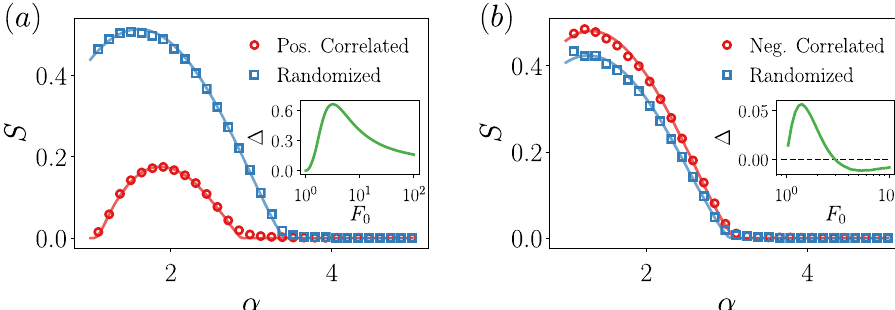
Fig. 3 Percolation in correlated degree-feature networks. Size of the giant connected component for ( a ) the positively correlated distribution Eq. (10) and for ( b ) the negatively correlated distribution Eq. (14), and their randomized counterparts. All nodes with feature F ≥ F 0 = 3, are removed. Points are the results from simulations and the solid line comes from the theory. Network sizes are N = 2 16 and each point is averaged over 100 realizations. In the inset of the panels, we display Δ ( F 0 ), corresponding to the area between the randomized and correlated curves and de fi ned in Eq. (13), as a function of the feature threshold. The integral has been computed in the region α ∈ (1,